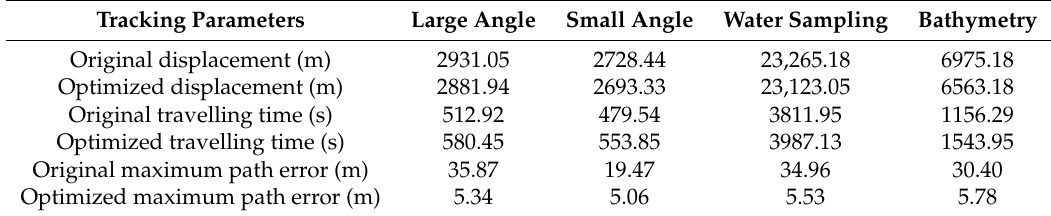
Table 5. Tracking parameters of USV with and without route